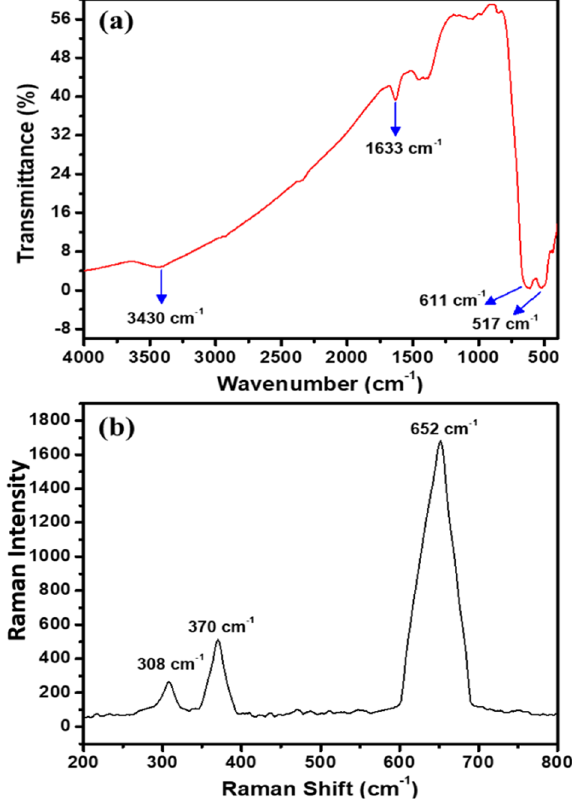
Figure 4. ( a ) FTIR spectrum and ( b ) Raman spectrum for α -MnO 2 nanowires.